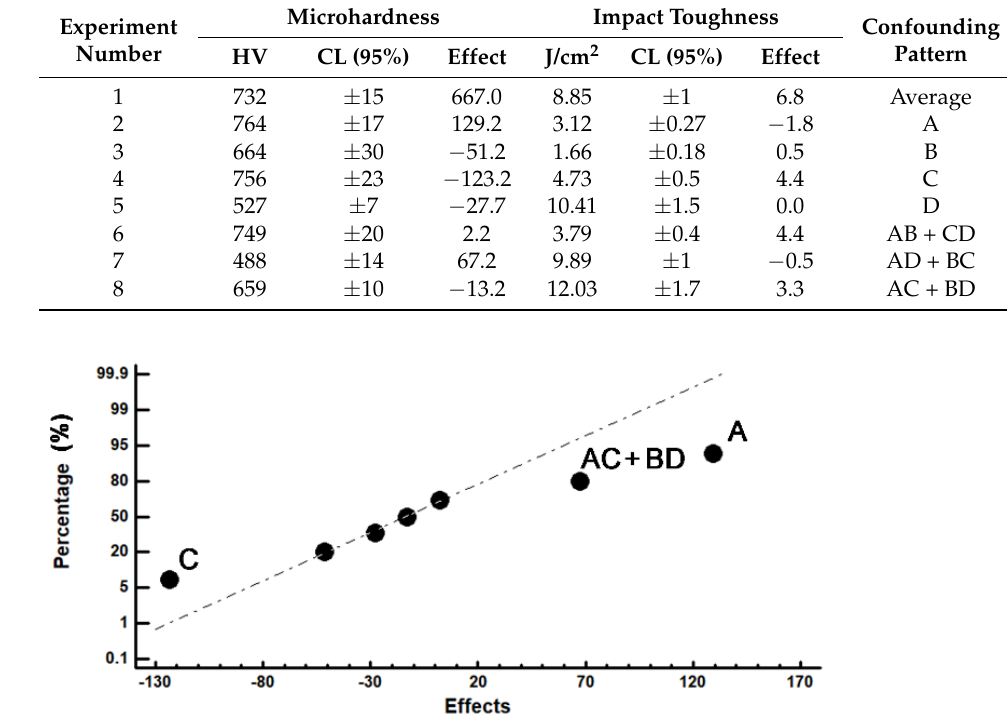
Table 7. Average values and standardised effects obtained for the microhardness of the matrix constituent and the impact toughness measured in a Hounsfield balanced impact machine.